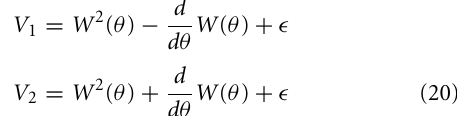
FIGURE 5 | Views of the lowest six eigenenergy surfaces, n = 0 , 1 , 2 , 3 , 4 , 5, of Hamiltonian (Equation 1) for a planar quantum pendulum subject to combined orienting and aligning interactions. The energy surfaces are shown as